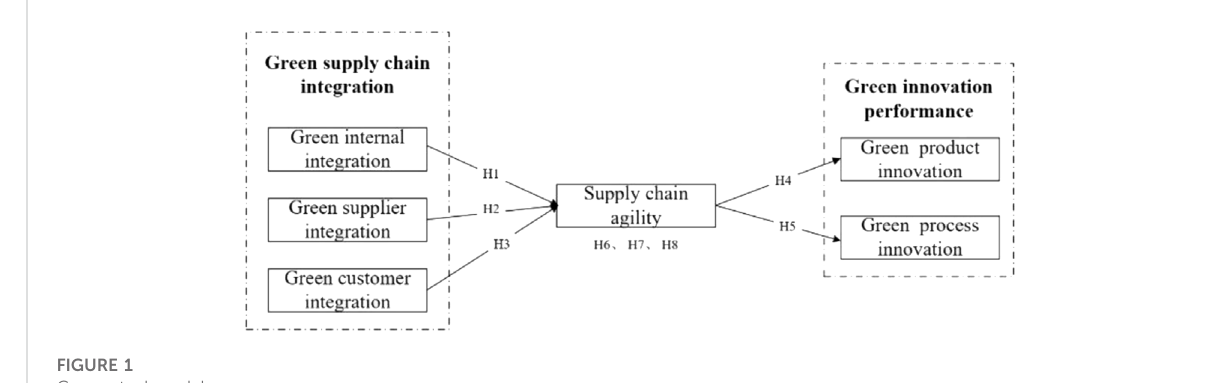
FIGURE 1 Conceptual